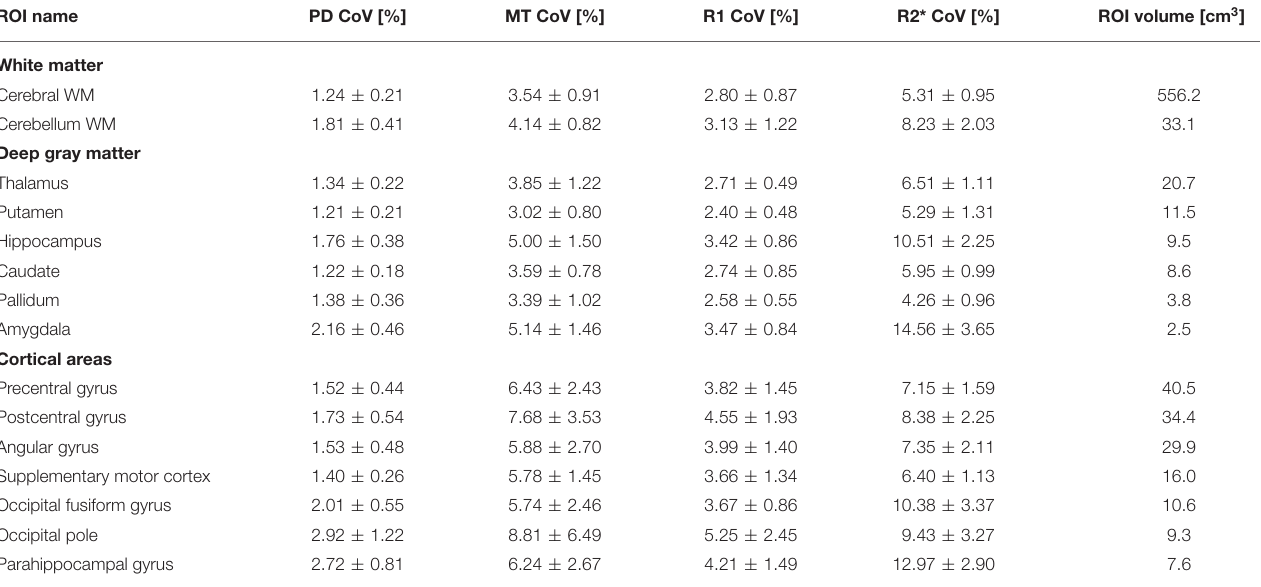
TABLE 2 | Mean and standard deviation of intra-subject CoV (scan-rescan) and volume of 15 example atlas regions with high clinical relevance (see remaining atlas regions as sortable table at